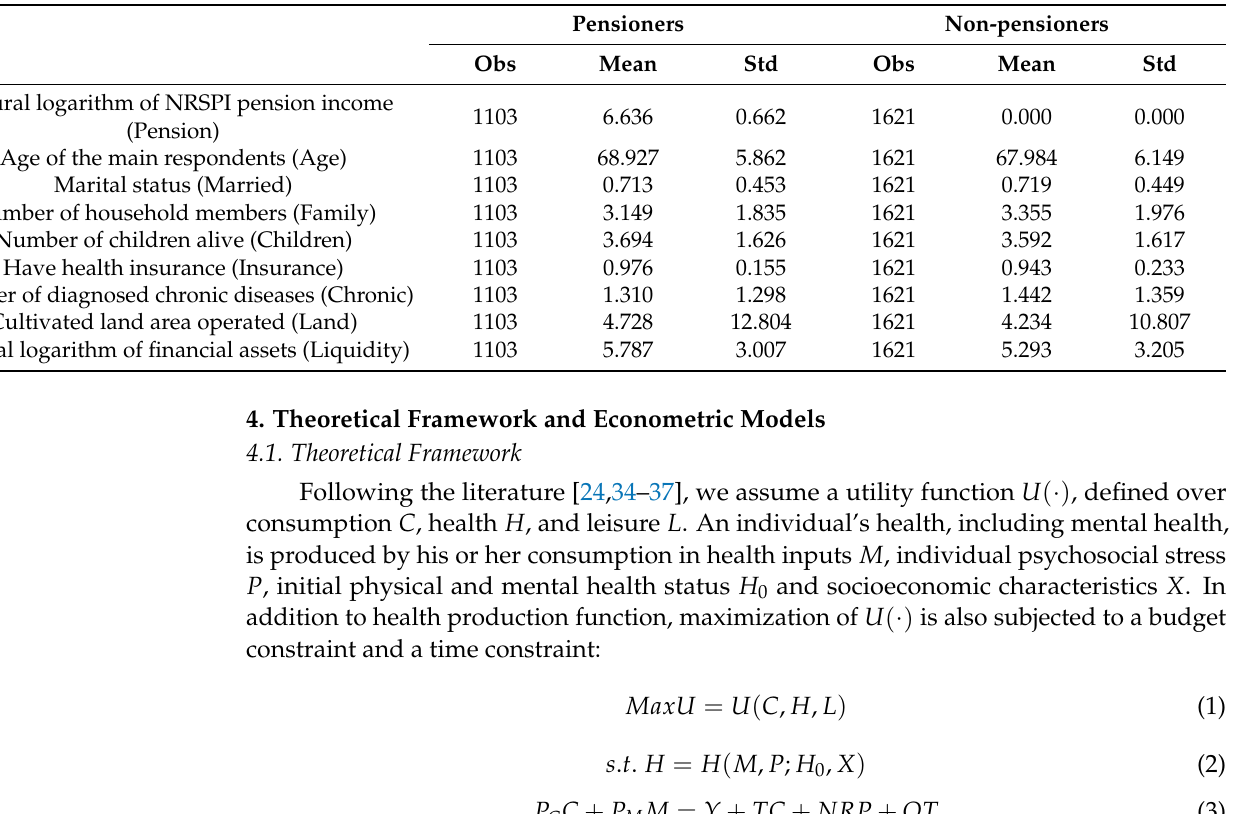
Table 3. Variable definition and descriptive